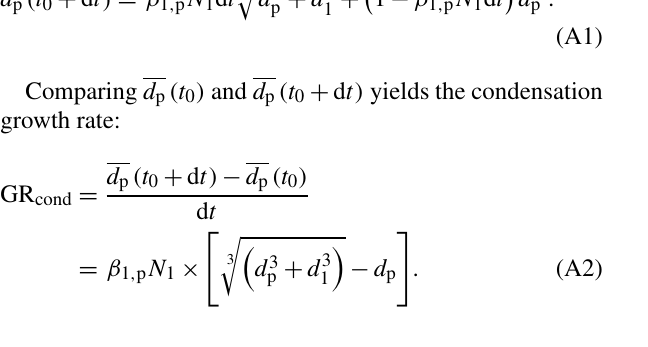
Table A1. The mean and maximum relative errors in the conventional and corrected appearance time methods for 1.5–3nm particles. The terms conv. and corr. are short for the conventional and corrected methods, respectively. The vapor concentration is assumed to follow a normal distribution with a peak concentration of N max and a standard deviation of σ t . Background CS characterizes the concentration of 100nm background particles. The errors are given in relative values. The results of the no. 8 test are shown in Fig. 6. No. N max (cm − 3 ) σ t (h) Background Mean error Mean error Max. error CS (s − 1 )